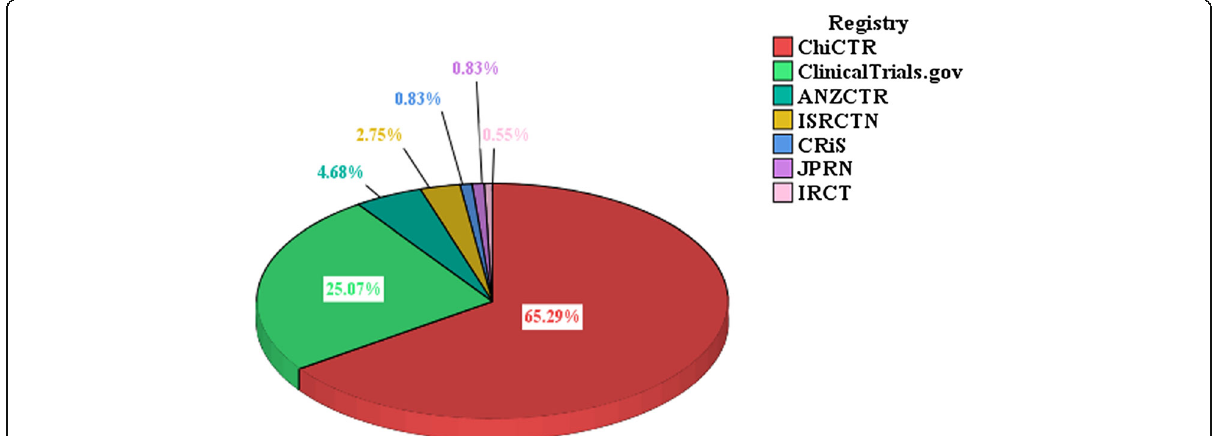
Fig. 3 Distribution of CHM-placebo controlled trials in 7 registries from 2002 to